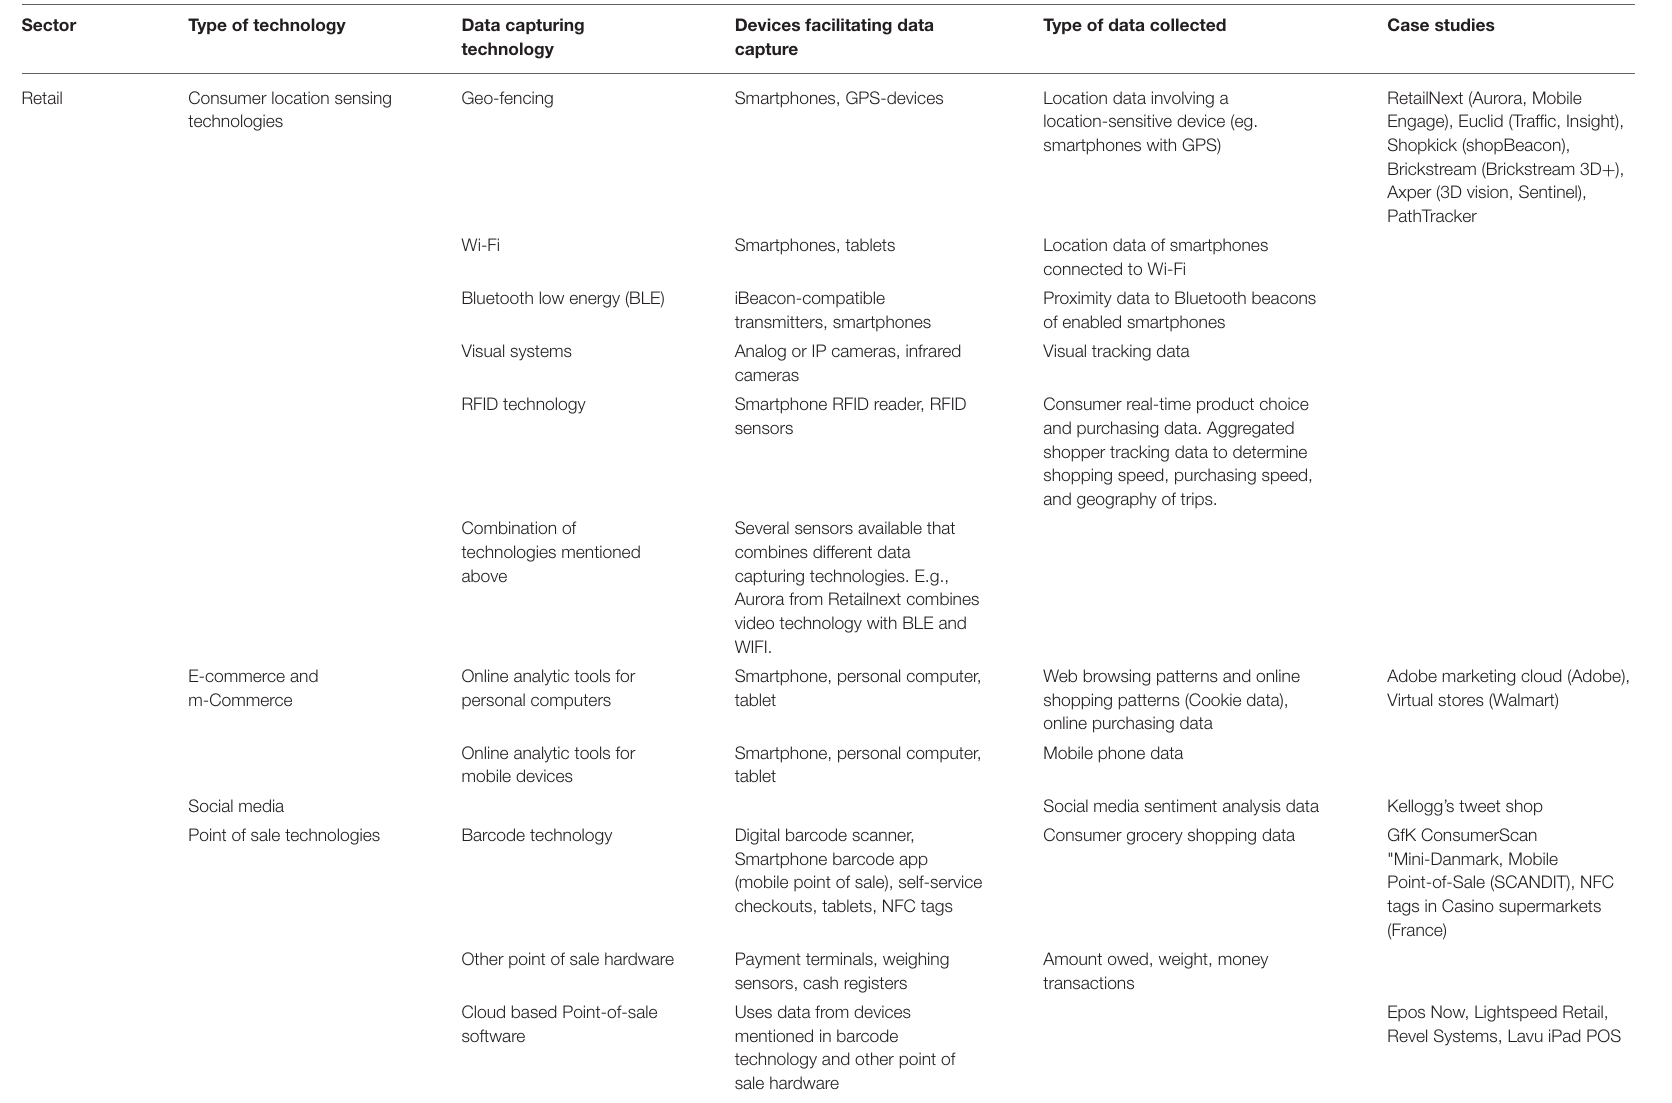
TABLE 2 | Review of ICT used by retail and market research organizations.